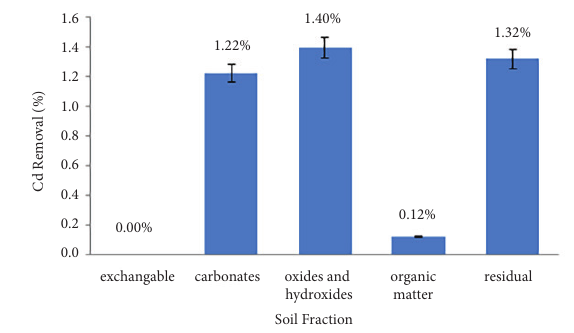
Figure 9. Sequential extraction of cadmium from contaminated soil after washing with nanofluid (Concentration = 500 ppm, pH = 6.5, Contact time = 24 hr, ratio of soil mass (gr) to nanofluid volume (mL) =